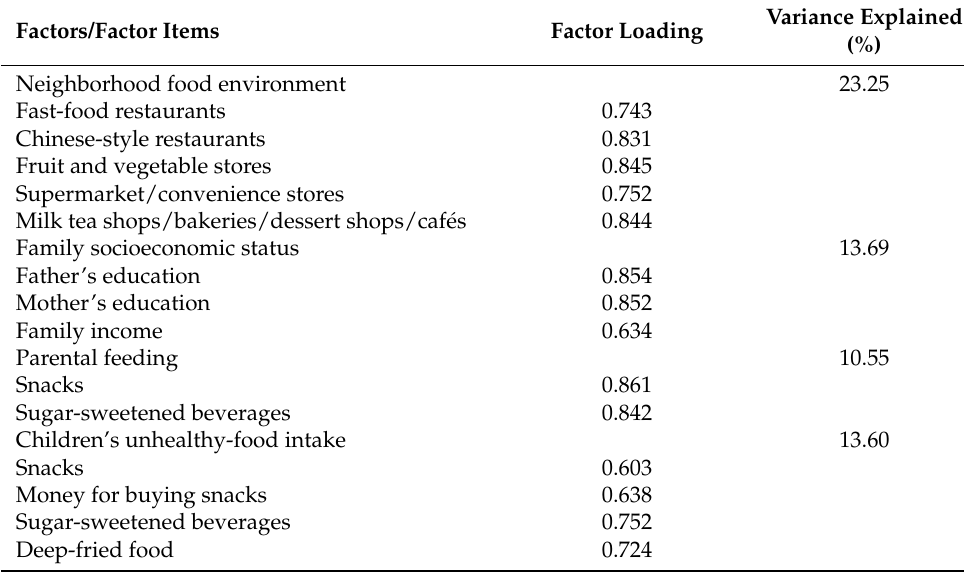
Table 3. Exploratory factor analysis with Varimax rotation and internal consistency for factors and their respective